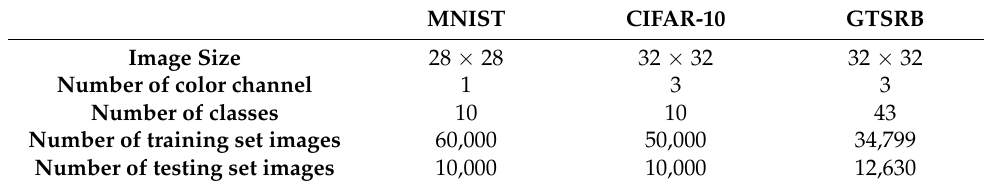
Table 1. Parameters of image datasets used in